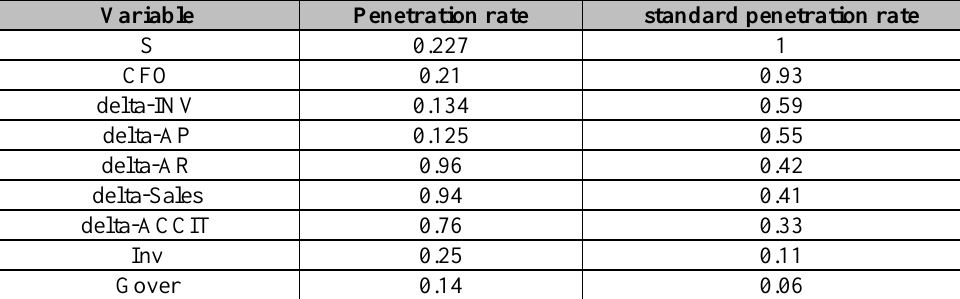
Table 14. Variables effect embellishment on prediction with 8 hidden nodes model